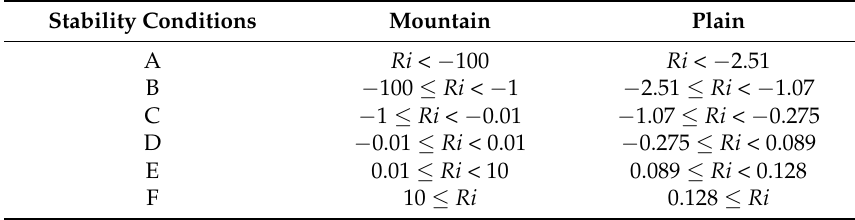
Table 1. Classification of stability based on Ri in different terrain conditions.